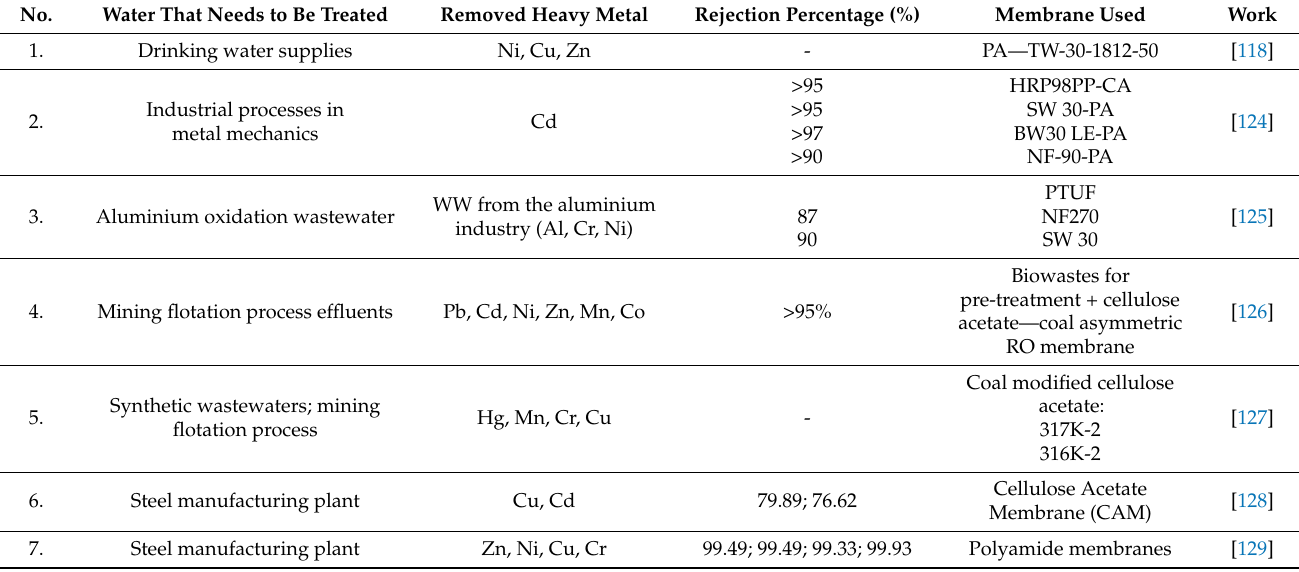
Table 2. Reported membranes and their